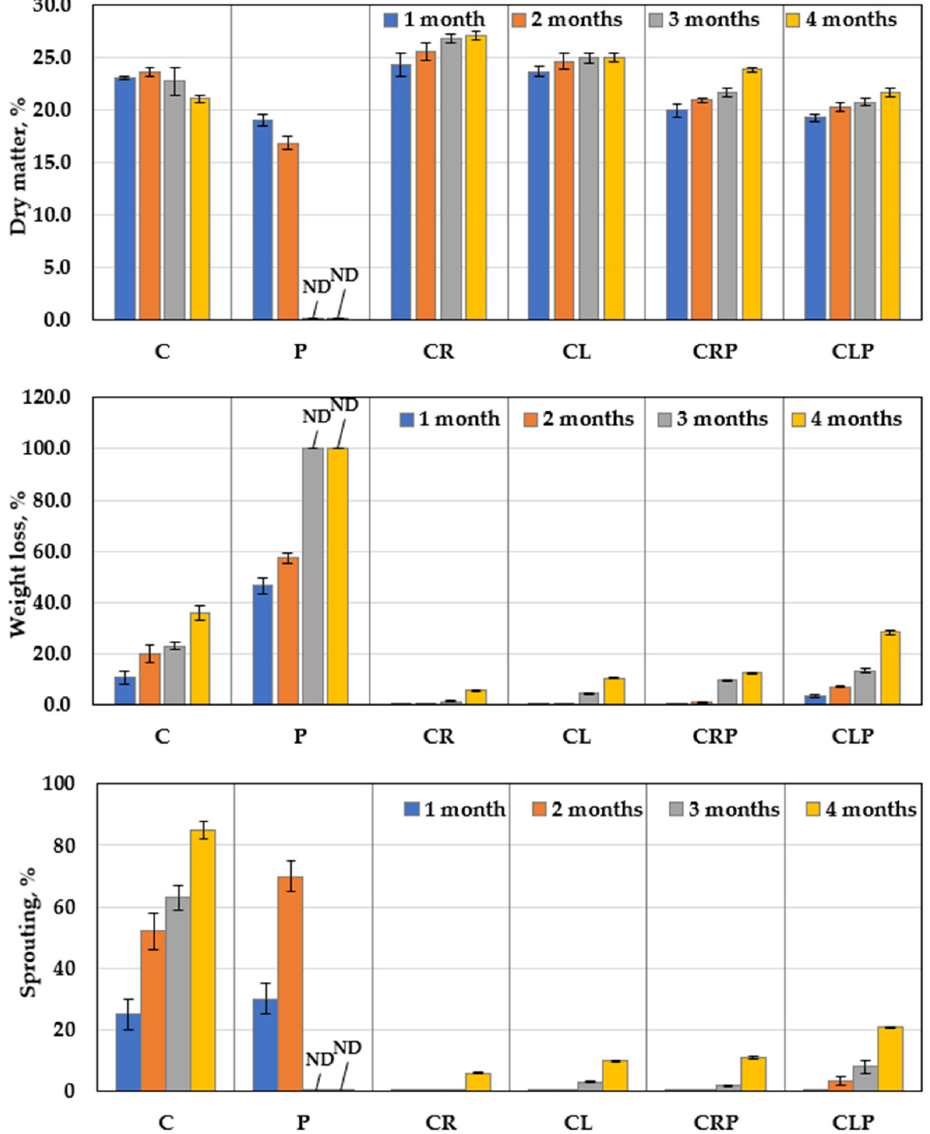
Figure 11. Comparative response features of JA tubers treated with essential oils after infection with P. polonicum under storage at 25 ± 2 °C (mean ± SD). C: untreated control; P: untreated infection by P. polonicum (ARS20); CR: treated with caraway oil; CL: treated with clove oil; CRP: treated with caraway oil plus infection by P. polonicum ; CLP: treated with clove oil plus infection by P. polonicum ; ND: not determined due to full deterioration.